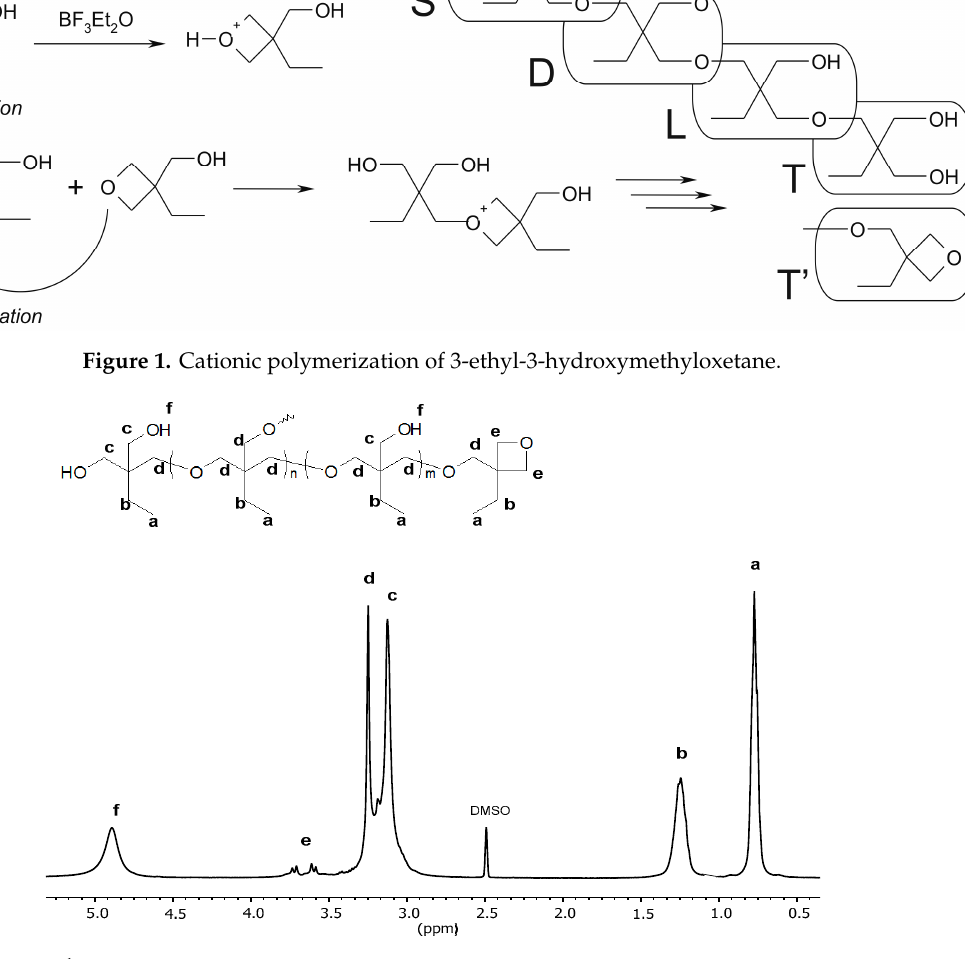
Figure 2. 1 H NMR (400 MHz, DMSO-d 6 ) spectrum of poly(3-ethyl-3-hydroxymethyloxetane). Figure 2 shows a typical NMR spectrum of hyperbranched